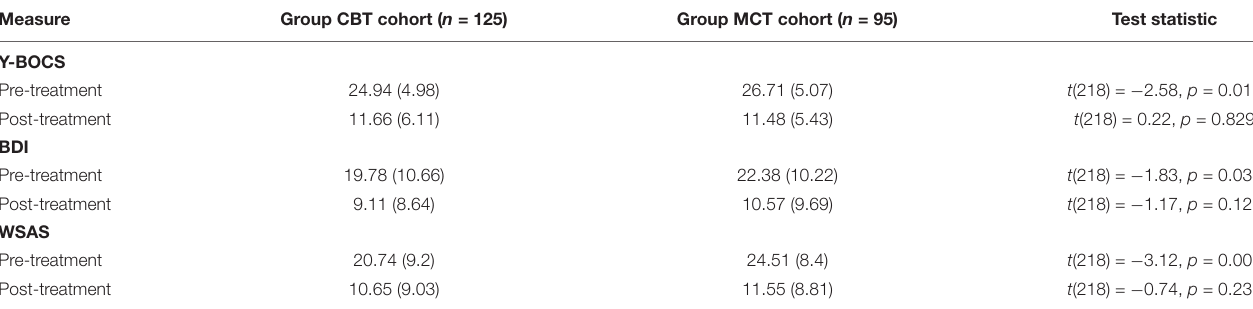
TABLE 2 | Means, SD (in parentheses), and summary statistics for the primary and secondary outcome measures before and after each group treatment. Measure Group CBT cohort ( n = 125) Group MCT cohort ( n =